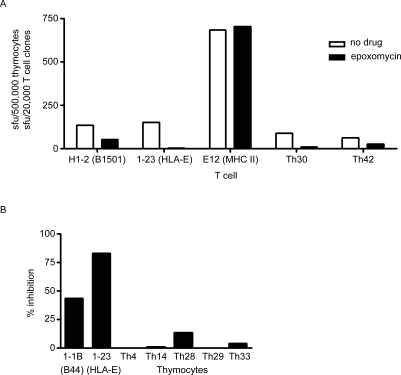
Activation of Mtb-Reactive Thymocytes Is Proteasome Dependent but Is Not Blocked by the Pan–HLA-I Antibody W6/32(A) DC were pretreated for 1 h with epoxomycin (1 μM). The DC were then infected with Mtb (moi 25). After 24 h, the drug was washed away and DC were fixed with cold paraformaldehyde (0.1%) for 5 min, washed twice in PBS, incubated for 2 h in media, and then washed three times. The DC (50,000 cells/well) were added to T cell clones (5000 cells/well) or CD4-depleted thymocytes (250,000 cell/well). Comparable results were obtained in 3 separate experiments.(B) Mtb-infected DC were incubated with the W6/32 antibody (2 μg/ml) or a mouse IgG2a isotype control (2 μg/ml) for 15 min before the addition of CD8+ T cell clones (10,000/well) or CD4-depleted thymocytes (250,000/well). IFN-γ production was evaluated by ELISPOT. The percent inhibition was calculated from the response to Mtb-infected DC in the presence of the W6/32 blocking antibody divided by the response to Mtb-infected DC in the presence of the isotype control.